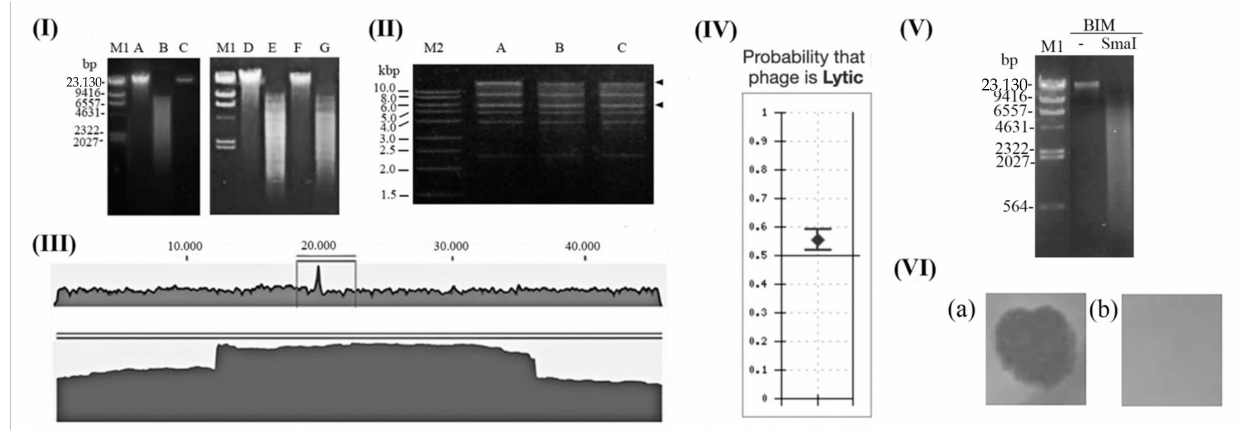
Figure 2. Determination of Pseudomonas phage Delta properties and lifestyle: ( I ) PAO 1 genomic DNA (A, D and F) was treated with SmaI (B) generating numerous fragments of small size; phage Delta DNA was not cut by SmaI (C); after PAO1 infection at MOI = 0.1 phage Delta genome was not detected in PAO1 genome (E), and similar was confirmed when PAO1 was infected at MOI = 10; ( II ) phage Delta DNA cut by BamHI show no change of restriction pattern after fast and slow cooling, indicating absence of cos site; ( III ) DNA sequence of phage Delta showed elevation of reads typical for direct terminal repeats; ( IV ) PHACTS algorithm showed that phage Delta is obligatorily lytic, with high confidence; ( V ) uncut and SmaI-cut BIM genome showed absence of phage DNA and thus lysogeny; ( VI ) lysis of sensitive P. aeruginosa lawn by phage Delta ( a ) and absence of lysis of BIM ( b ).